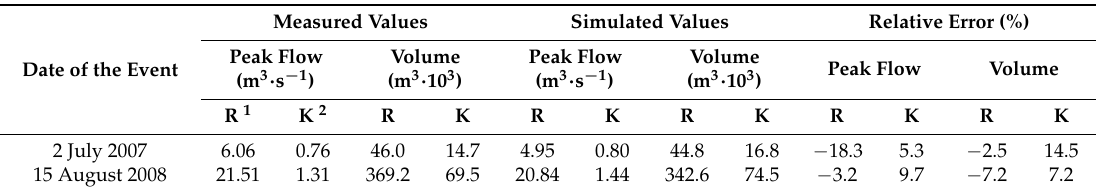
Table 3. Results using rainfall depths measured at rain